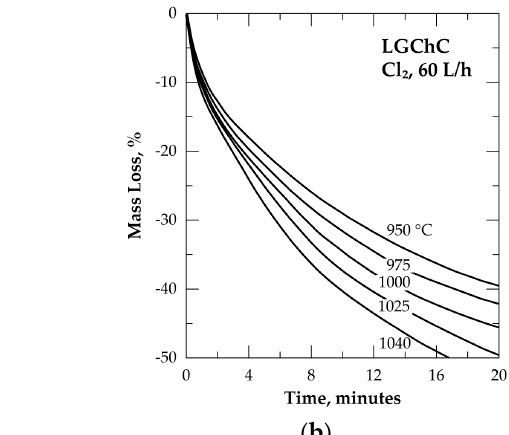
( c ) Figure 7. Comparison of the thermal behavior of LGChC and HGChC in Cl 2 atmosphere: ( a ) 800 °C; ( b ) 950 °C; ( c ) 1040 °C.